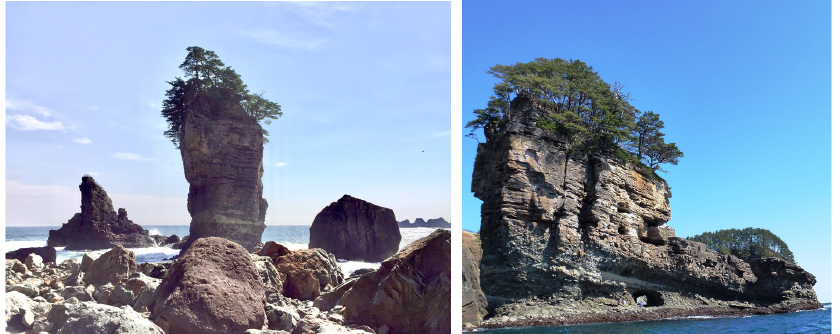
Figure 1. The Sanouiwa (Three Kings) rock formation, consisting of Otokoiwa and Onnaiwa (left), and Taikoiwa (right) in Miyako City, Iwate Prefecture, Japan. The figure on the left shows the 50 m high Otokoiwa (Male Rock) and the 23 m high Onnaiwa (Female Rock), while the figure on the right shows the 17 m high Taikoiwa (Taiko Drum Rock). These rocks were shaped by wave and wind action over a period of 100 million years. The horizontally striped sandstone surface and loose rubble combine to evoke scenes of the ancient Cretaceous period [2]. These three rocks, which stand adjacent to one another, were listed as an Iwate Prefectural Natural Monument on 4 September 1992, and are now part of the Sanriku Fukko National Park. After the new designation, facilities for tourists and visitors, including a promenade, were constructed and have been maintained since. Following the Great East Japan Earthquake of 2011, even though these famous rocks withstood the massive tsunami that struck the area, damage to the handrail and other portions of the promenade prompted prefectural authorities to prohibit entry to the rocks temporarily. It was also decided to digitally record the rock formation in its current state for posterity and to ensure that a record existed in the event of future damage to the mon- ument. To digitally archive these large coastal rocks, we used an unmanned aerial vehicle (UAV), or drone, and global navigation satellite system (GNSS) data. The drone, which was equipped with a remotely operated, high-resolution camera, was piloted above and around the rocks in order to capture 1015 high-resolution images. To prevent capturing blurry images and to improve measurement accuracy, images were captured with the drone maintained in a stationary position. In order to unify the geographic coordinates of the obtained data, five georeference markers were placed near the beach and near the Sanouiwa rock formation. By ensuring that these markers were visible in the images captured by the drone-mounted camera, positional information could then be measured via the GNSS data with reference to each marker. Using these high-resolution images, we then generated large point cloud datasets of the coastal rocks using three-dimensional (3D) shape reconstruction software. The 3D shape reconstruction software utilizes a structure-from-motion (SfM) method to generate the point cloud data. Since the point cloud data thus generated were very large and noisy, we cleaned up and reduced the number of points in the cloud data to facilitate analysis. Finally, we constructed the 3D digital model based on the point cloud data by using 3D modeling software with a mesh generation function, and then produced physical 3D models using two different 3D printers. Our physical 3D models have been evaluated as being effective at many exhibitions and public information sessions [3].